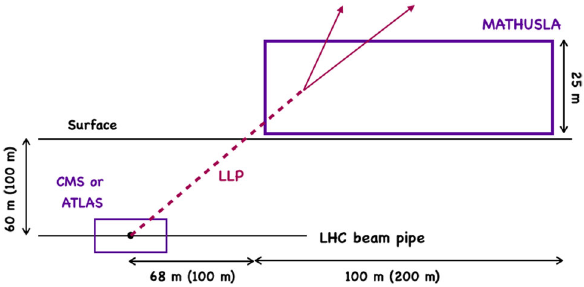
Fig. 12 SchematicdiagramoftheMATHUSLAdetector.Intransverse direction the range of MATHUSLA is taken as 60–85 m (100–125 m), whereas inthe longitudinal directionitis considered as 68–168 m (100– 300 m)